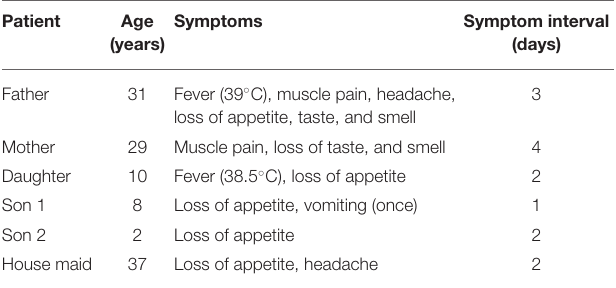
TABLE 1 | Summary of the symptoms in family members during the course of